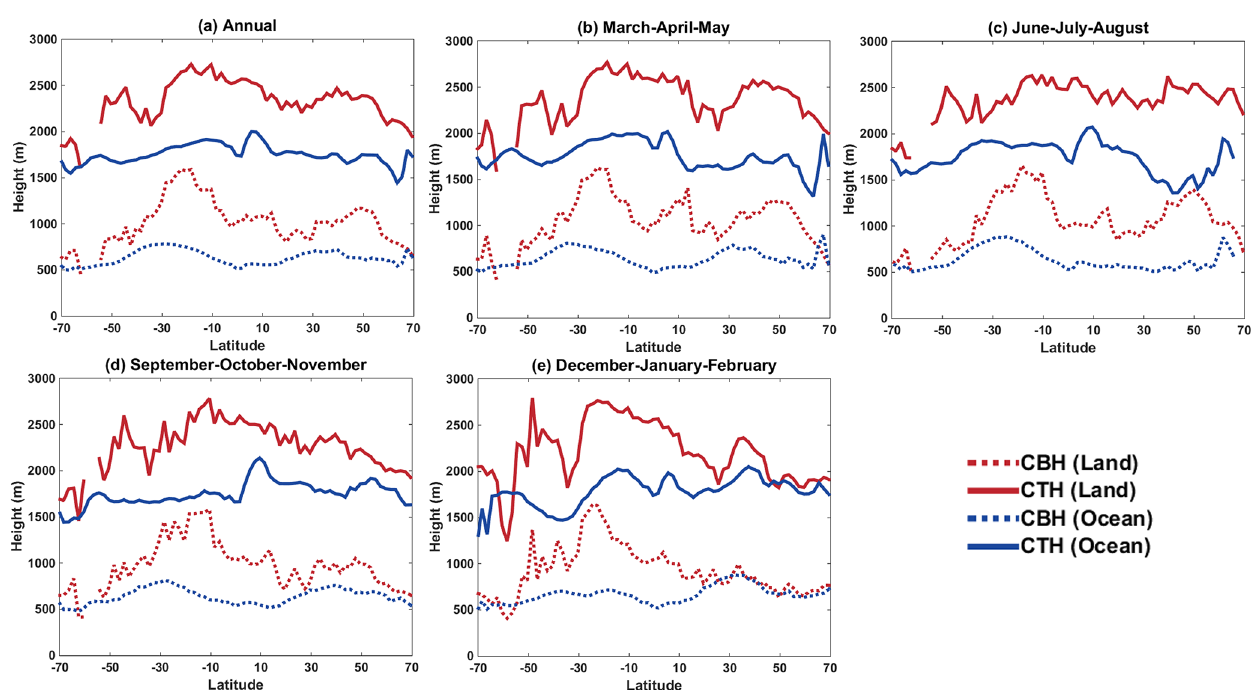
Figure 13. Mean meridian CBH and CTH annual and seasonal distributions. Straight lines indicate CTH, and dotted lines indicate CBH (ocean in blue, land in red). (a) Annual; (b) March, April, and May; (c) June, July, and August; (d) September, October, and November; and (e) December, January, and